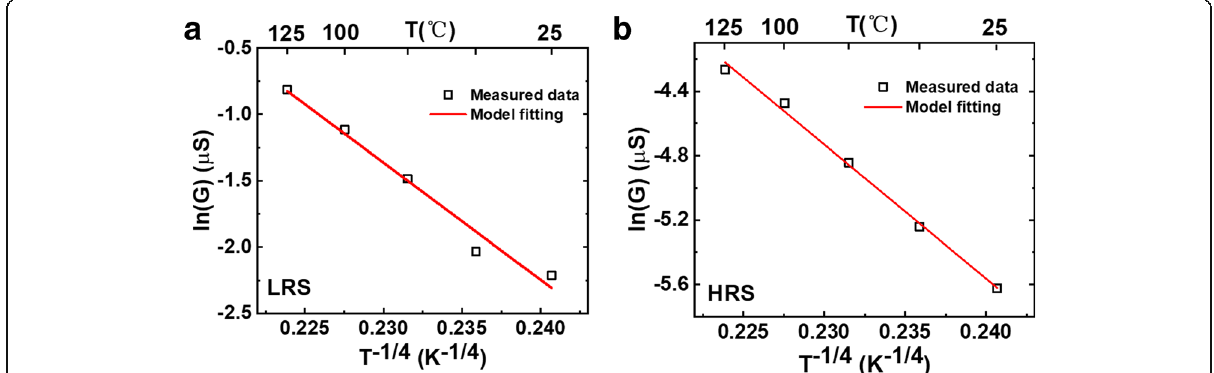
Fig. 11 Temperature dependence of the conductance of S1 in a LRS and b